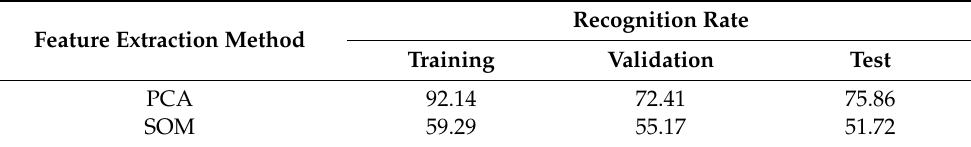
Table 3. Recognition rates (for training, validation and test set) for an MLP classifier trained with features received with PCA and SOM application.